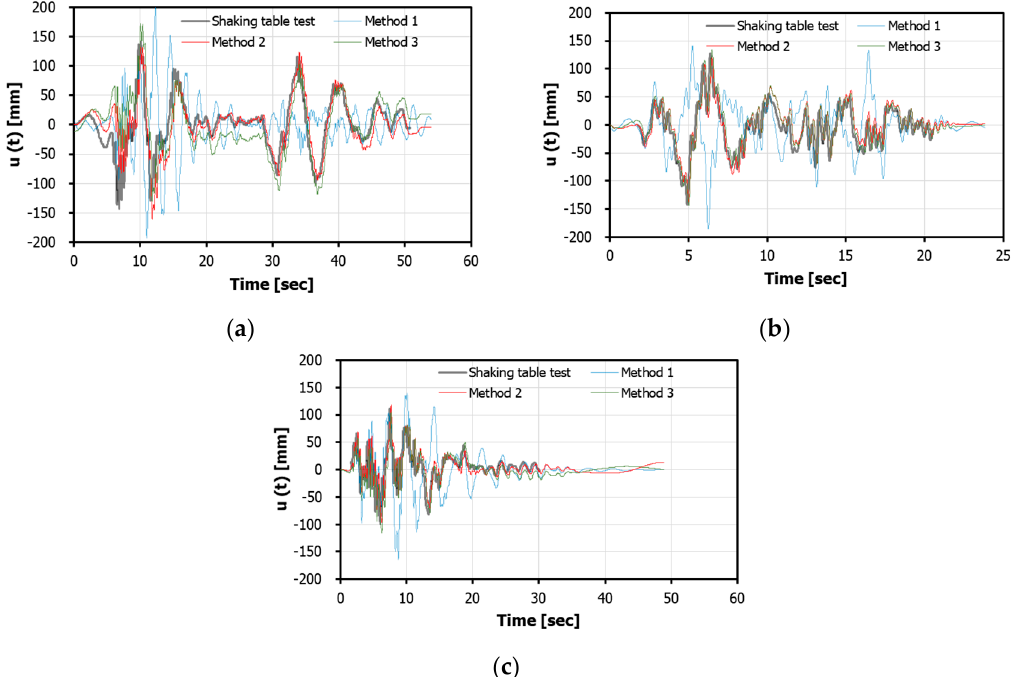
Figure 20. Analysis process for the 10th-story acceleration during the Kobe earthquake using Method 3: ( a ) 2nd-order polynomial equation for correcting acceleration; ( b ) 4th-order Butterworth high-pass filter; ( c ) acceleration; ( d ) velocity; ( e ) displacement.